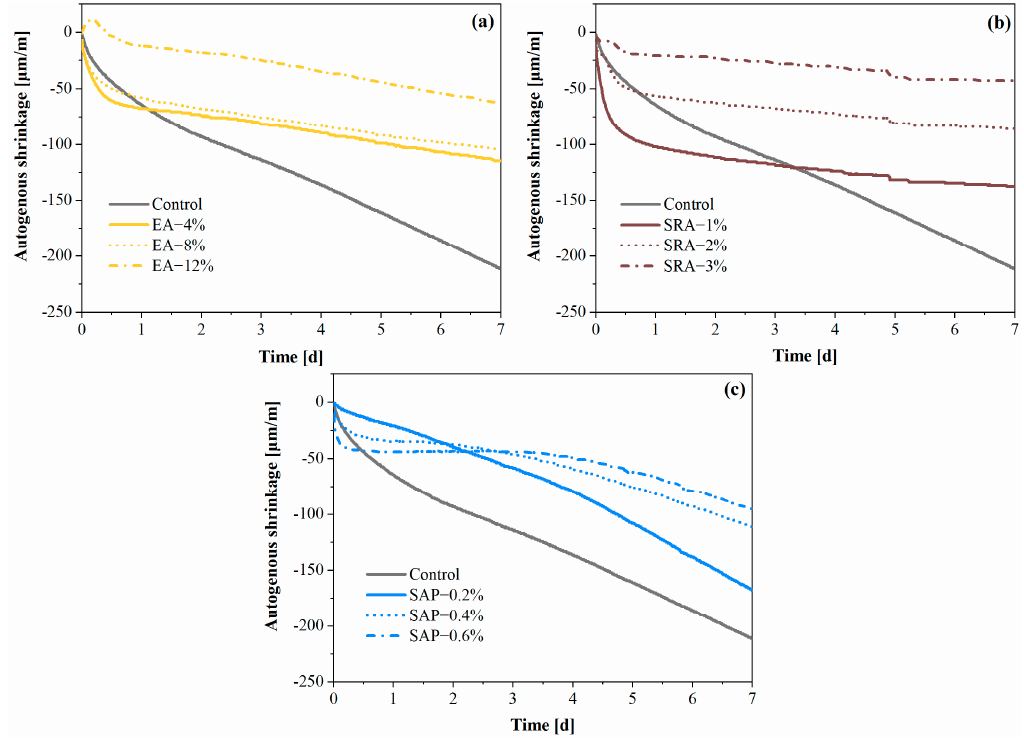
Figure 9. Autogenous shrinkage of secondary lining concretes: ( a ) EA ( b ) SRA ( c ) SAP. As shown in Figure 9b, with the addition of SRA, the autogenous shrinkage of concrete gradually decreases. Compared with the control, the autogenous shrinkage of concrete with 3% SRA is reduced by 79.6% at 7 d. This was mainly related to the structure of